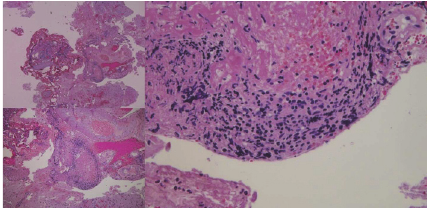
Figure 3: Brain biopsy pathology (day 50). Brain tissue fragments with hematoxylin and eosin stain showing blood vessels surrounded by predominantly mononuclear cells. Occasional thrombi are present as well as fibrinoid and liquefactive necrosis. No granulomas or multinucleated cells are seen.